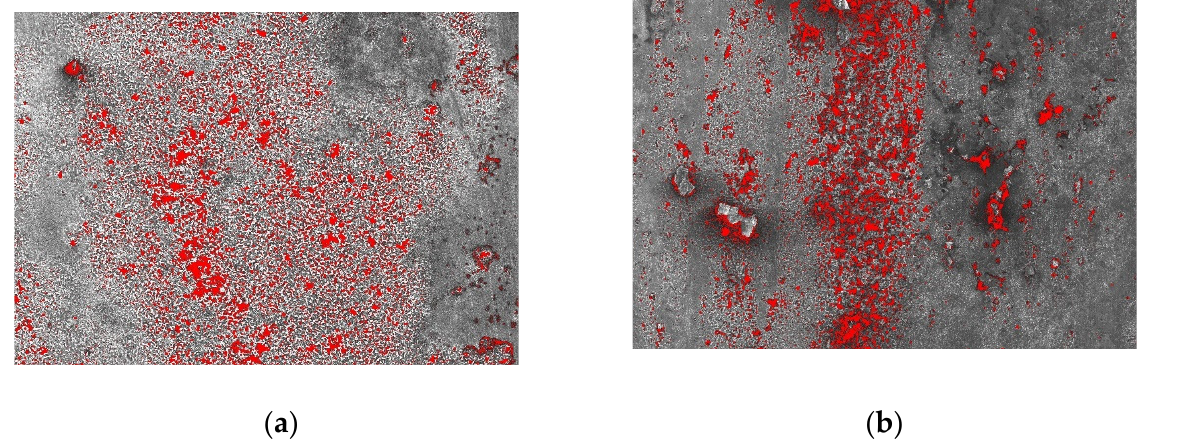
Figure 12. Pit area to whole area ratio of ( a ) pure corrosion test electrode and ( b ) erosion corrosion test electrode.